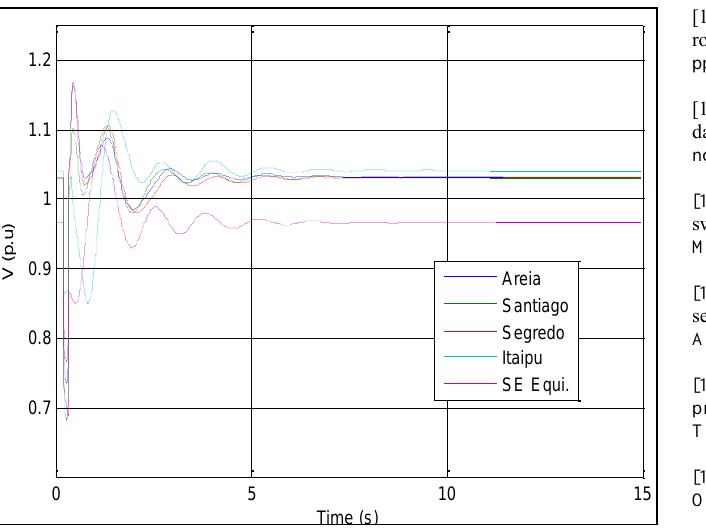
Figure 8: Generation bus voltage -